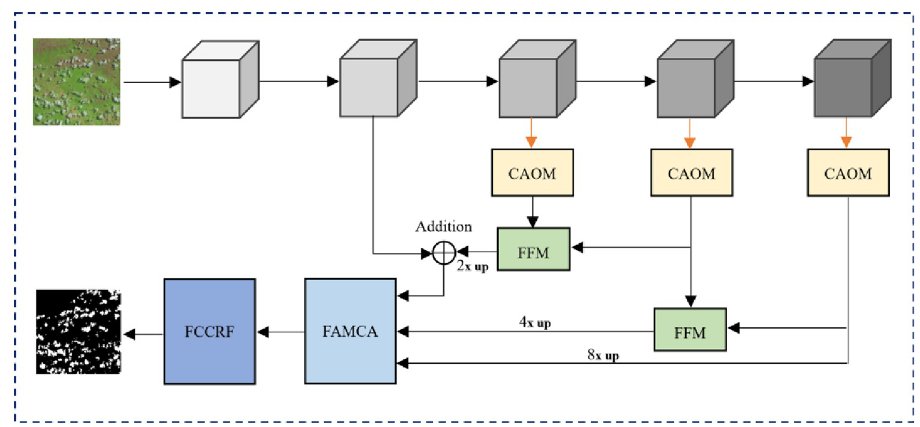
Fig 1. The main framework of our proposed